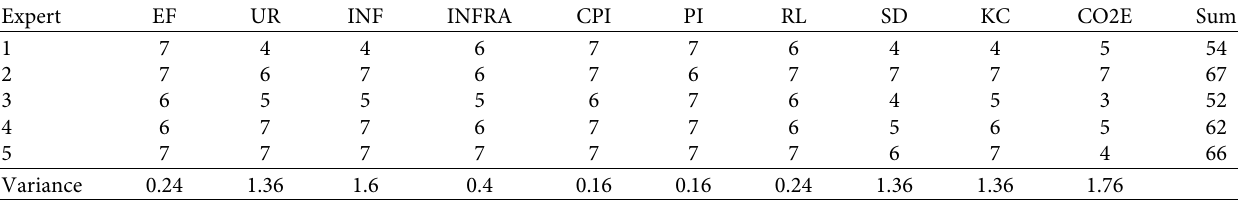
Table 5: Survey internal consistency